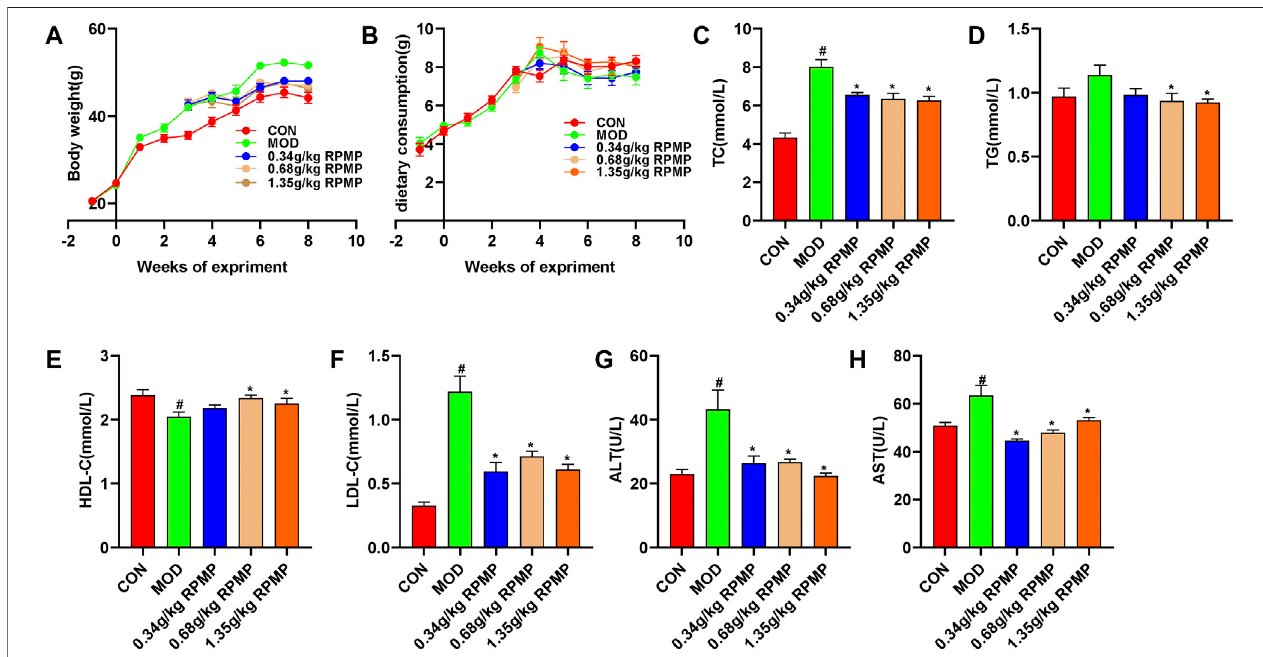
FIGURE3| EffectsofRPMPethanolextractonbodyweightandserumbiochemicalparametersinHFD-inducedmice. (A) Trendsinbodyweightofmice. (B) Curve ofweeklyfoodintakeinmice. (C – H) ,Serum biochemicalindicesofmice.Thedatawerepresented asthemeans ± SEM, # p < 0.05,compared withtheCON group; * p < 0.05, compared with the MOD group ( n (cid:2) 8).